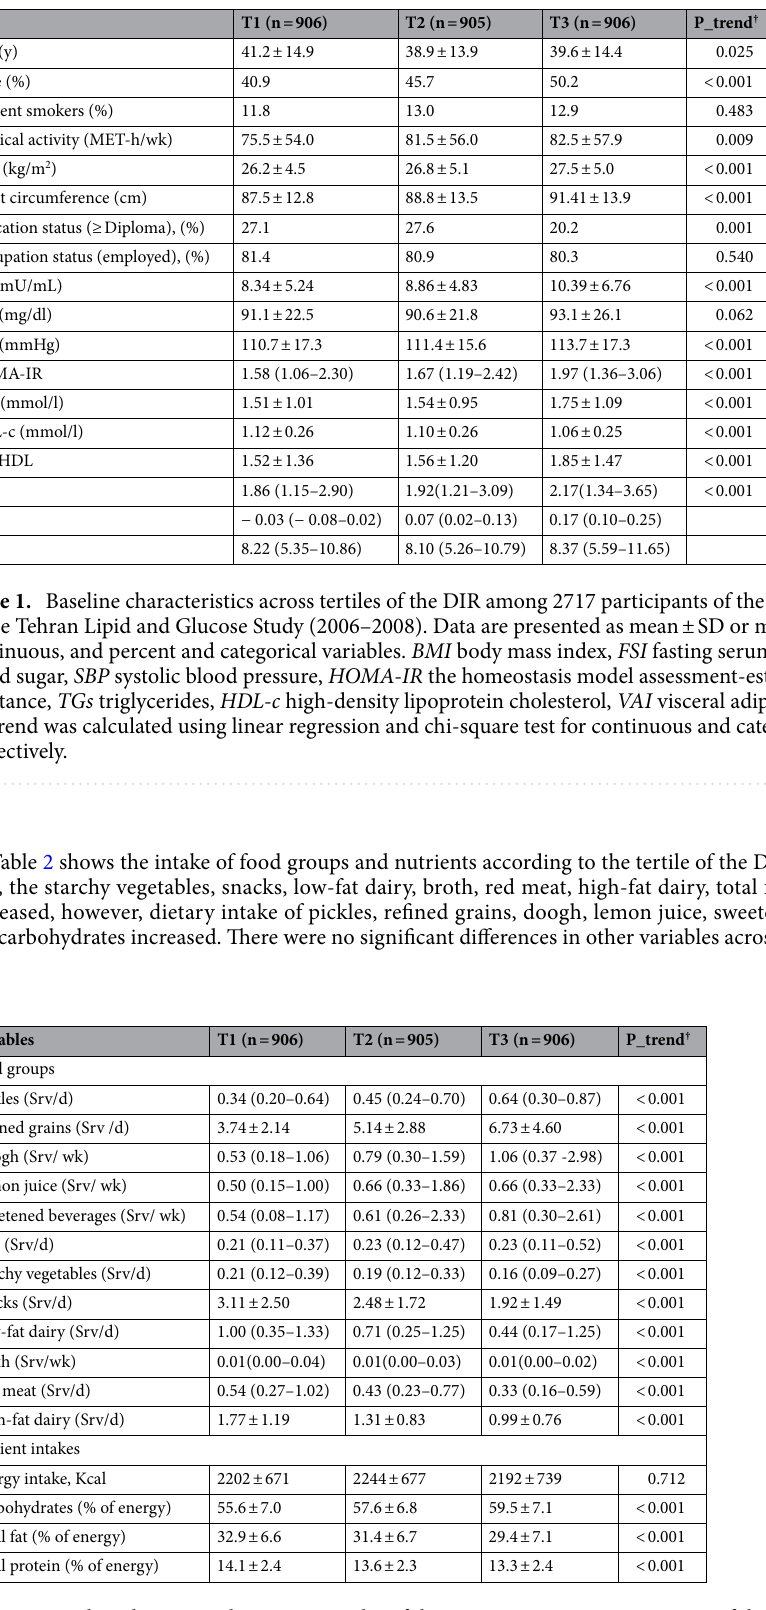
Table 2. Baseline dietary intakes across tertiles of the DIR among 2717 participants of the third examination of the Tehran Lipid and Glucose Study (2006–2008). Data are presented as mean ± SD or median (IQR). † P for trend was calculated using linear regression and chi-square test for continuous and categorical variables,